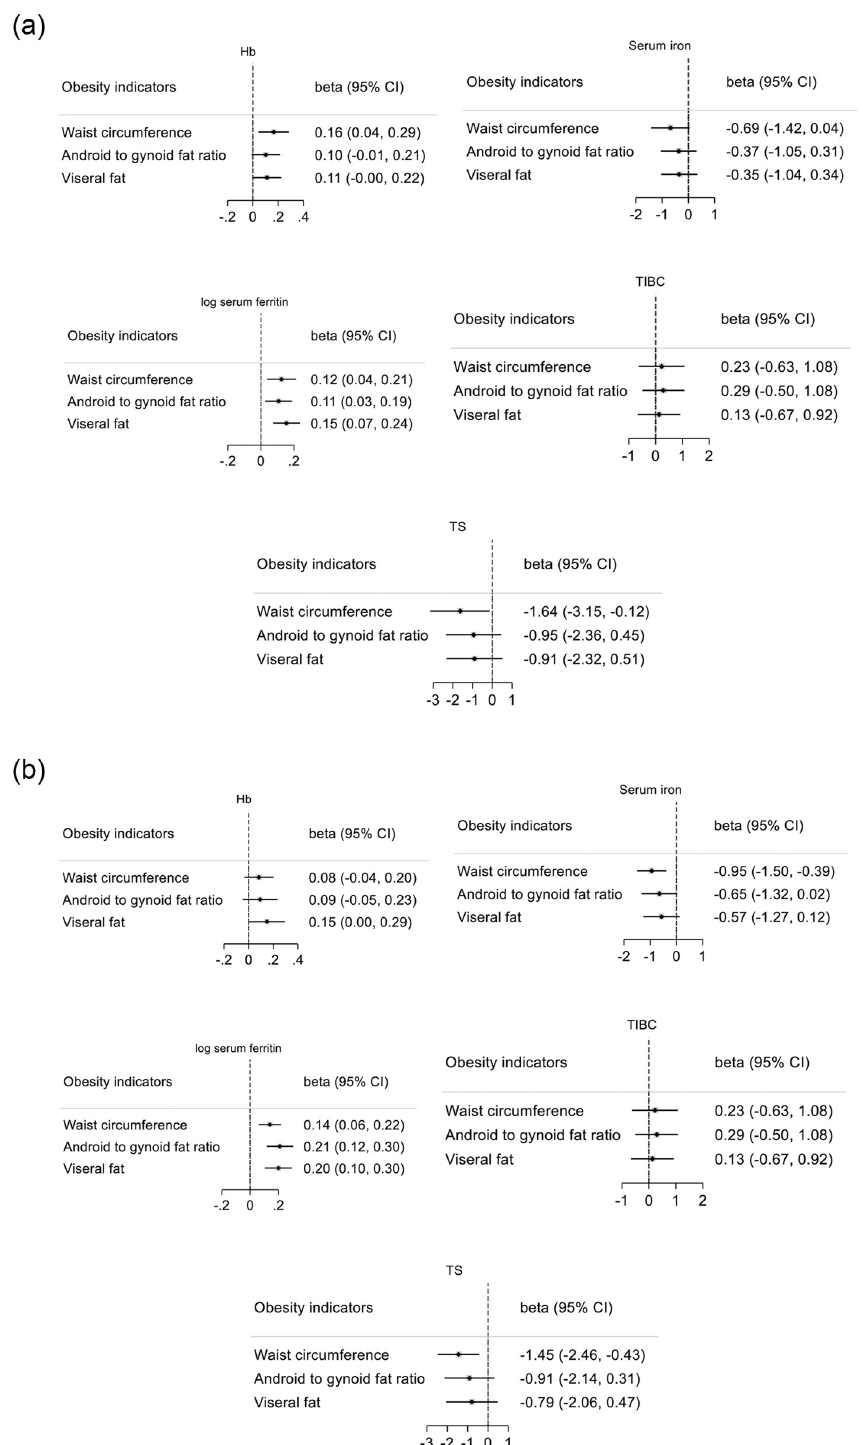
Fig 1. a: The correlation between the obesity indicators and the iron status indicators in men. b: The correlation between the obesity indicators and the iron status indicators in women.